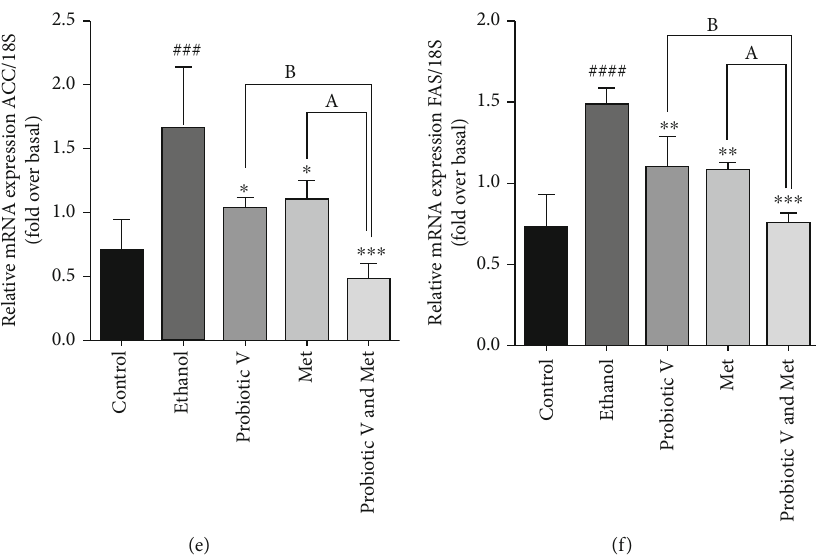
Figure 8: qRT-PCR analysis of (a) PPAR- γ , (b) HSL, (c) AMPK, (d) SREBP-1c, (e) ACC, and (f) FAS genes from ethanol-exposed HepG2 cells along with probiotic V and Met alone or together as probiotic V and Met combination for 48h. The gene expression levels were calculated after stabilizing against 18S rRNA in every sample and are represented as relative mRNA expression units. Values represent the mean ± SD of three individual experiments. Statistical signi fi cance was assessed by one-way ANOVA followed by Tukey post hoc test. Statistical analysis: ### p < 0 : 001 and #### p < 0 : 0001 compared with control group; ∗ p < 0 : 05 , ∗∗ p < 0 : 01 , ∗∗∗ p < 0 : 001 , and ∗∗∗∗ p < 0 : 0001 compared with ethanol group; A,B p < 0 : 05 , AA,BB p < 0 : 01 , and AAA,BBB p < 0 : 001 compared with probiotic V and Met combinatorial group. PPAR- γ : proliferator-activated receptor-gamma; HSL: hormone sensitive lipase; AMPK: adenosine monophosphate-activated protein kinase; SREBP-1c: sterol regulatory element binding protein 1c; ACC: acetyl-CoA carboxylase; FAS: fatty acid